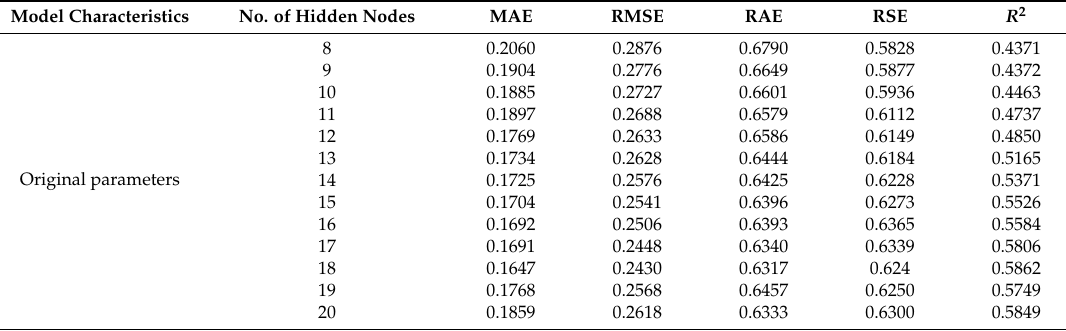
Table 9. Model validation with various neurons based on original dataset as input and PCA extracted components as